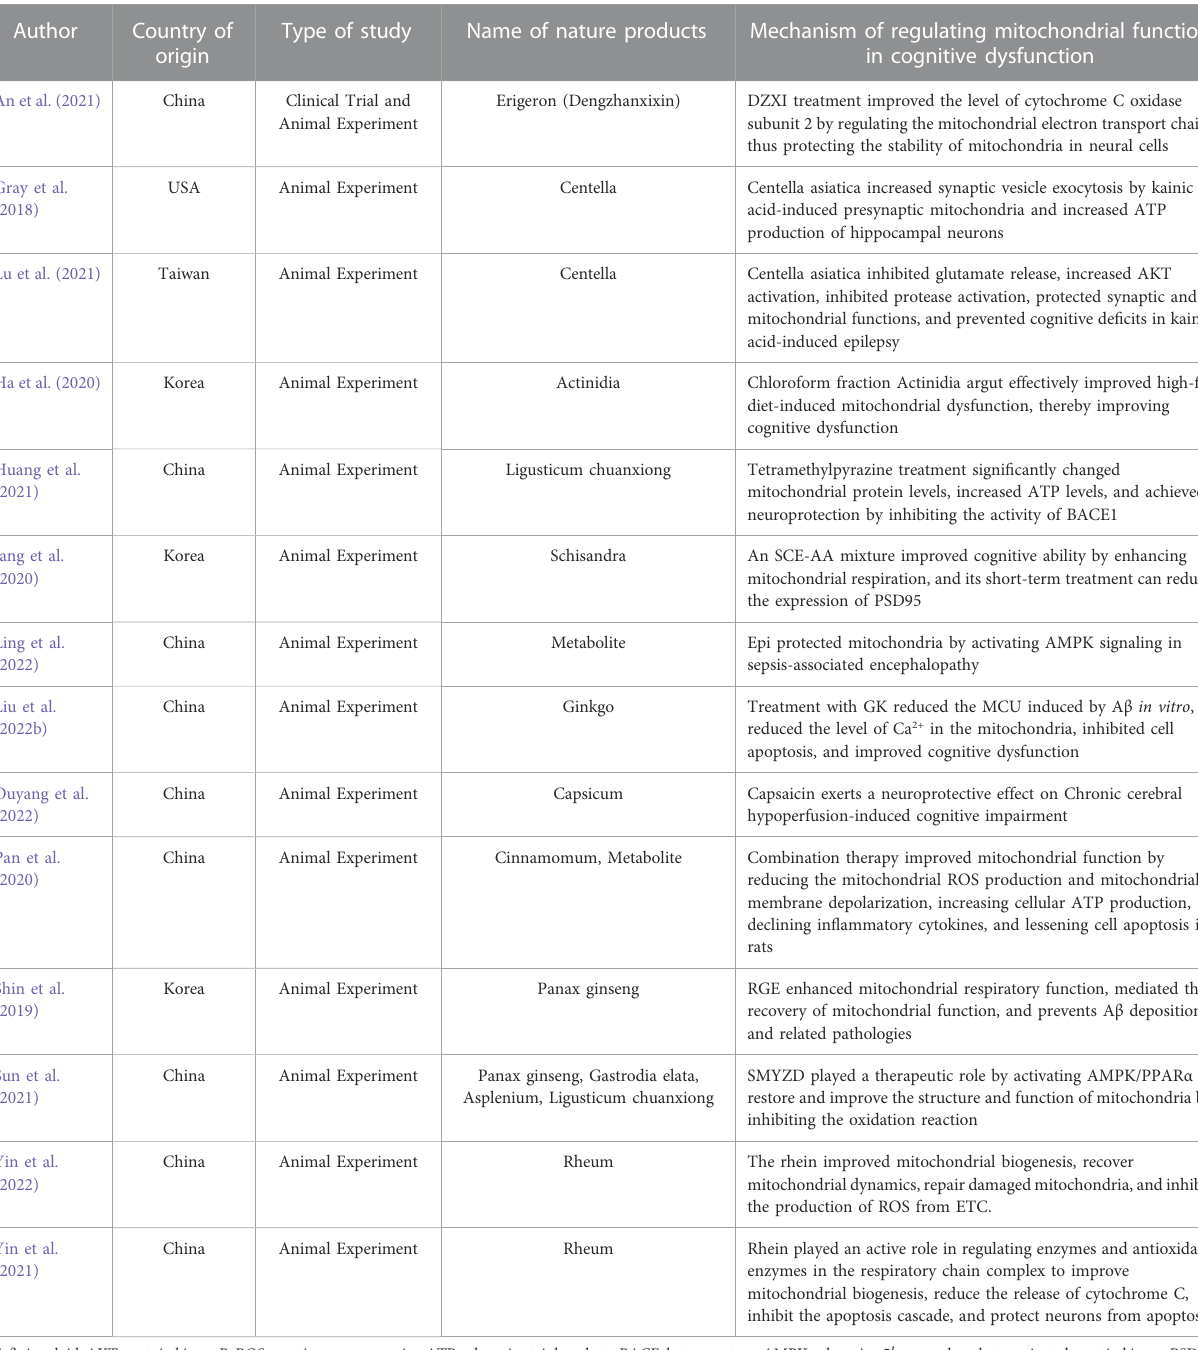
TABLE 1 Mechanisms underlying natural product regulation of mitochondrial function in cognitive